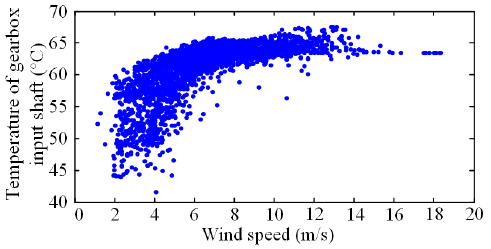
Figure 2. Relationship between the gearbox input shaft temperature of a variable speed constant-frequency (VSCF) WT and the wind speed.